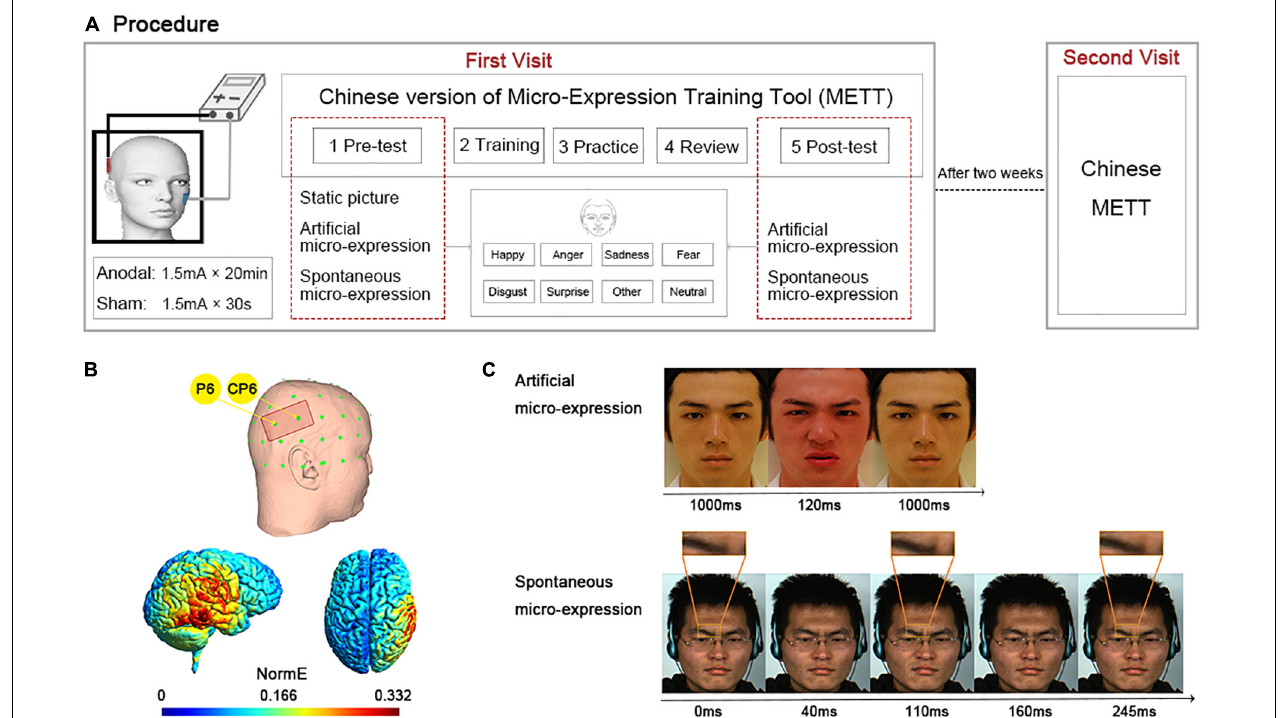
FIGURE 1 | Experiment design. (A) Experimental procedure. Two visits were made. In the first visit, participants underwent anodal or sham stimulation and then completed the Chinese version of Micro-Expression Training Tool (METT); in the second visit 2 weeks later, they only finished the Chinese version of METT. The Chinese version of METT included five sections, pre-test, training, practice, review, and post-test. In the sections of pre-test and post-test, participants were asked to choose one of eight emotion labels after seeing the stimuli. The stimuli of pre-test included static expressions, artificial and spontaneous micro-expressions. The stimuli of post-test included artificial and spontaneous micro-expressions. (B) Placement of the anodal electrode for the right temporal parietal junction (rTPJ) between P6 and CP6 regions (top row) and the normalized electric field (NormE) derived from electric field modeling calculations using SimNIBS (bottom row). (C) The time series of artificial and spontaneous micro-expression in disgust. Source: L.F. Chen and Y.S. Yen, Taiwanese facial expression image database, Brain Mapping Laboratory, Institute of Brain Science, National Yang-Ming University,